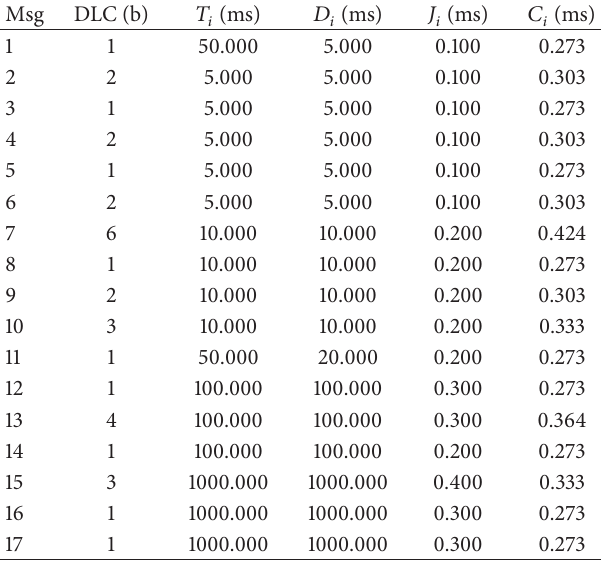
Table 2: Message parameters for the SAE benchmark